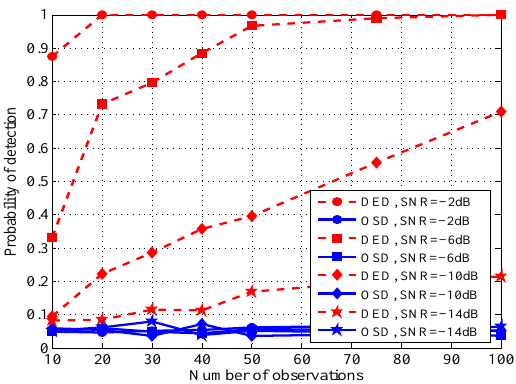
Figure 9. Probability of detection: DED and OSD vs. M for different average primary SNRs | Rayleigh fading | Mixture Gaussian noises | Gaussian primary signal.